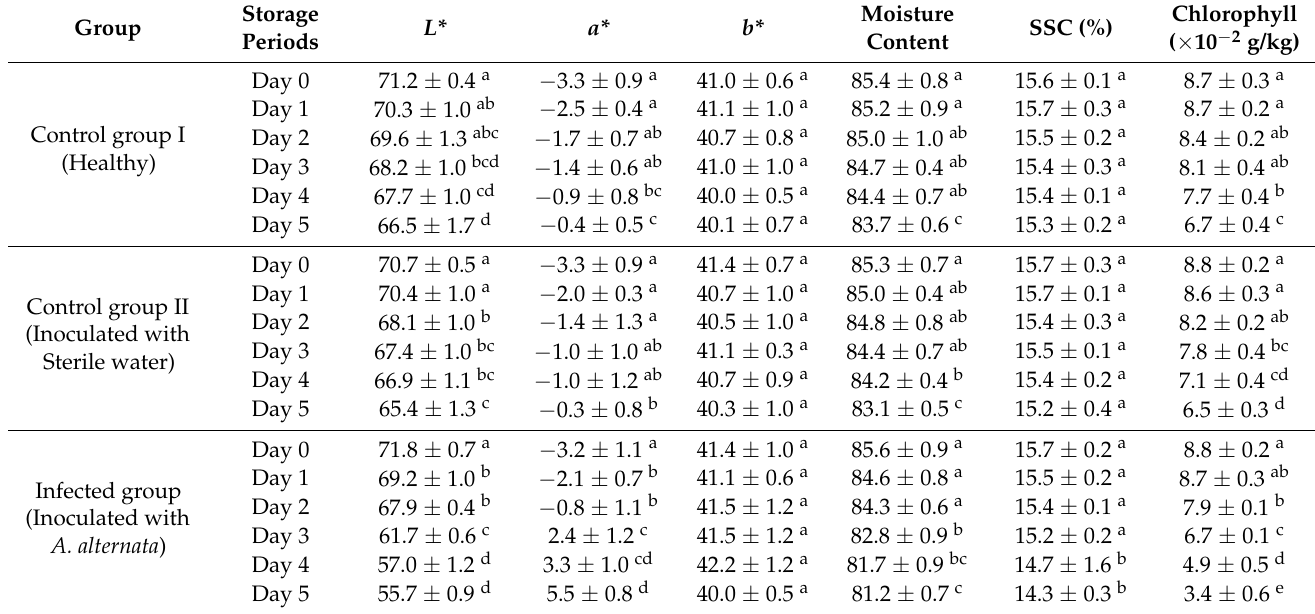
Table 1. Physical and chemical parameters of uninfected and infected winter jujubes during the storage at 20 ◦